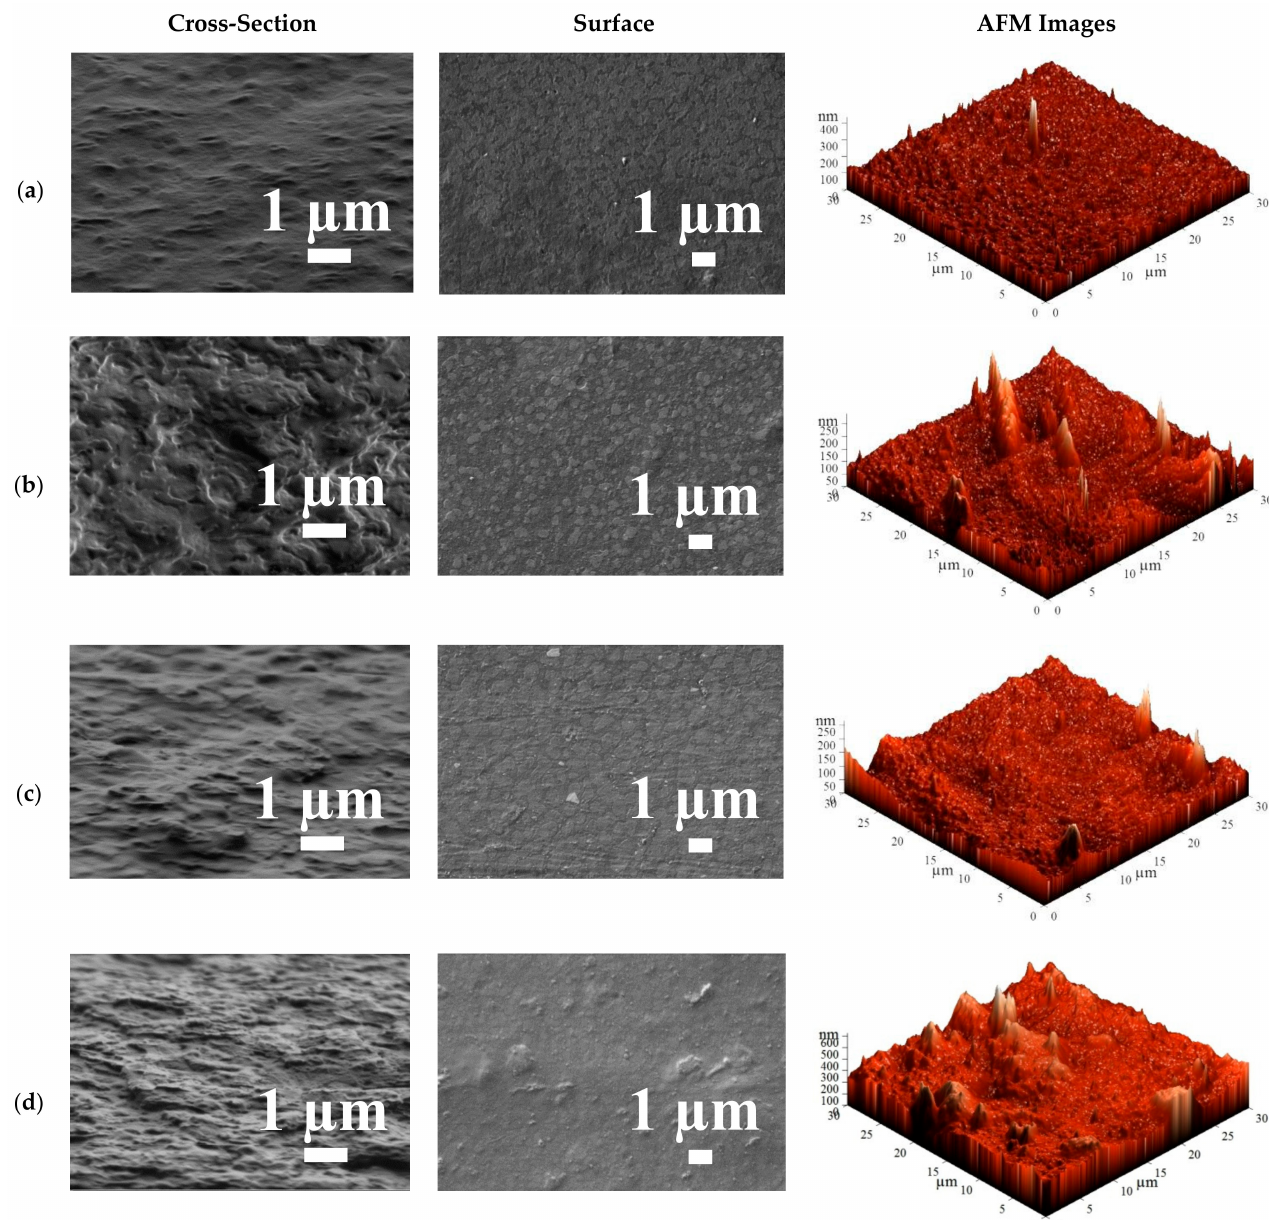
Figure 9. The cross-sectional and surface scanning electron microscopy (SEM) micrographs and atomic force microscopy (AFM) images of the HEC/SA membranes with different polymer weight ratios: ( a ) 10/90, ( b ) 30/70, and ( c ) 50/50 wt.%, and ( d ) HEC/SA-5